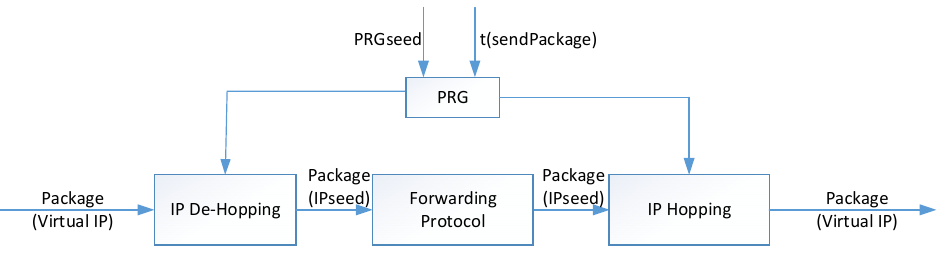
Figure 4. Generation of virtual IP address.